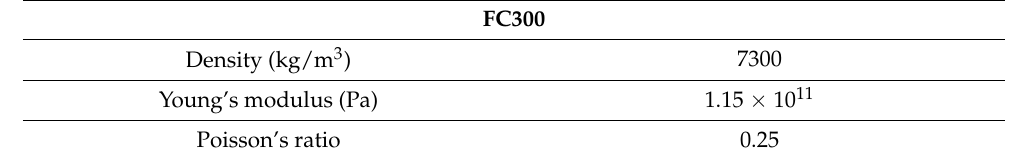
Table 2. FC300 properties [31].